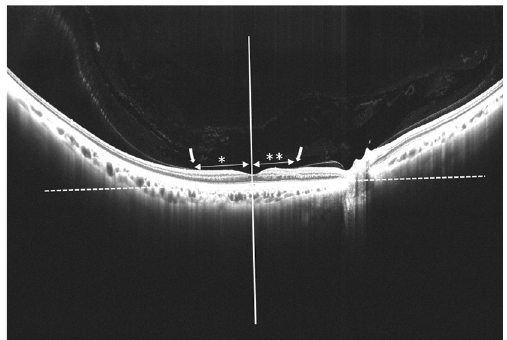
Figure 2. Quantitative evaluation of the point of vitreous detachment perpendicular line to the macula (PLM) indicated by a white solid line is assumed to pass the minimum distance from the center of the fovea to the choroidal line indicated by a white dot line. This is a tangent drawn to the outer border of the retinal pigment epithelium at the bottom of the foveal center. The distance of PLM to the point of vitreous detachment (white arrow) (PLM-VD) is measured for PVD staging. In this case, the temporal PLM VD (*) is 2568 µm, and the nasal PLM VD (**) is 1802 µm, both larger than 750 µm; therefore, the diagnosis is PVD stage